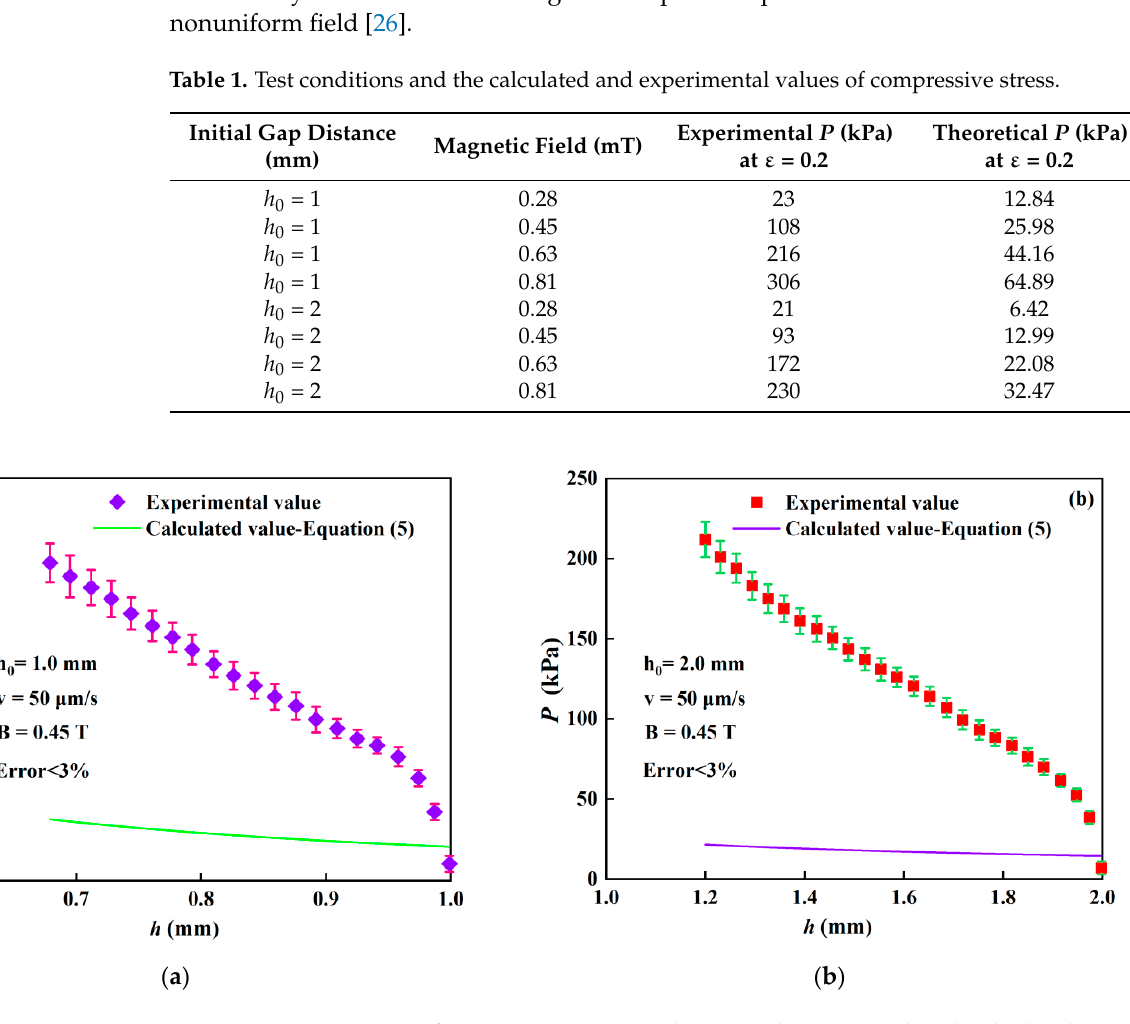
( b ) Figure 7. Logarithmic curves of compressive stress versus the instantaneous gap distance with different magnetic fields at v = 50 μ m/s. ( a ) h 0 = 1 mm; ( b ) h 0 = 2 mm.